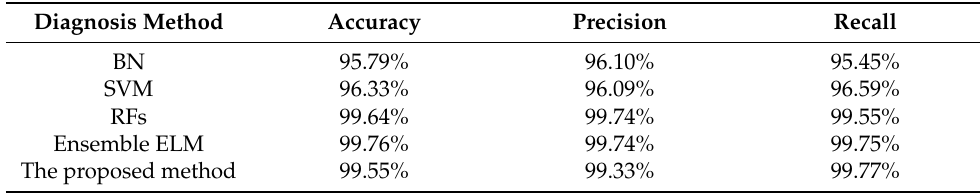
Table 6. The 10-fold cross-validation results.